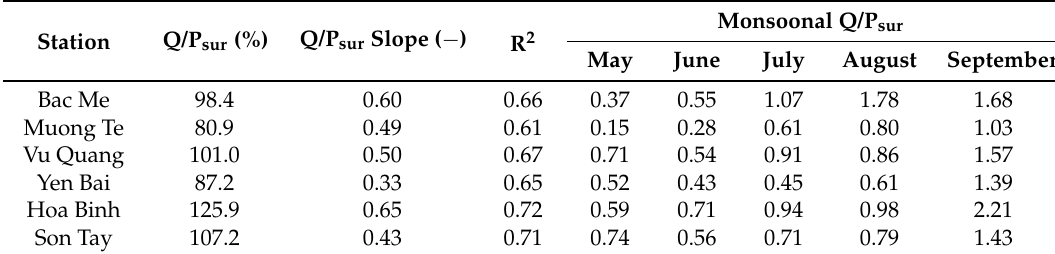
Table 7. Comparison of streamflow Q and rainfall surplus P sur for each catchment, with slopes and R 2 for linear relationships between monthly Q and upstream P sur . Also given are the values of Q/P sur during the rainy season. All values represent the 2003–2012 period.